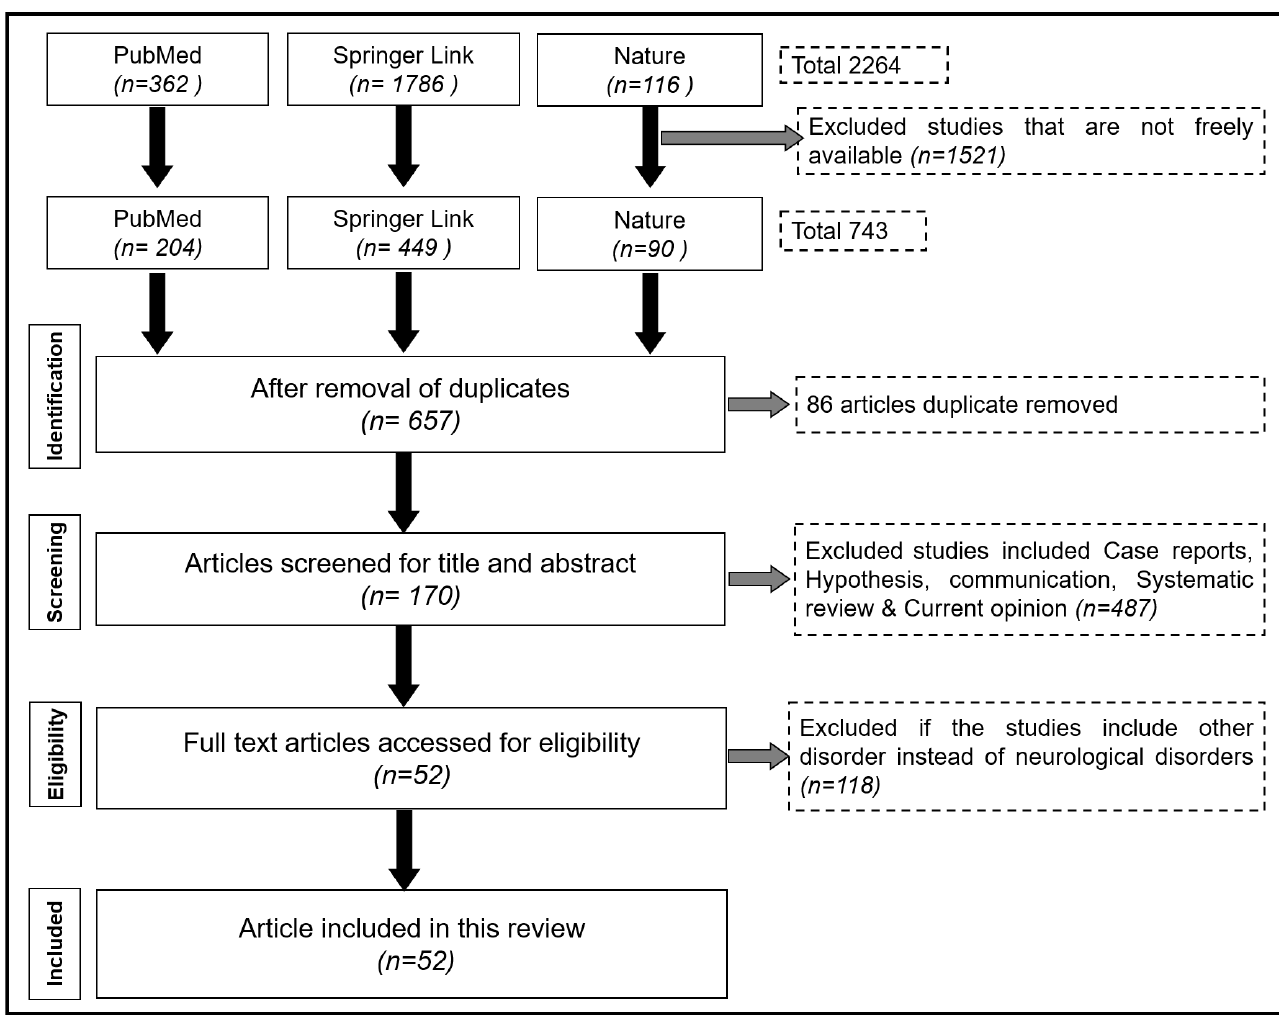
Figure 1. Identification and screening for literature search.